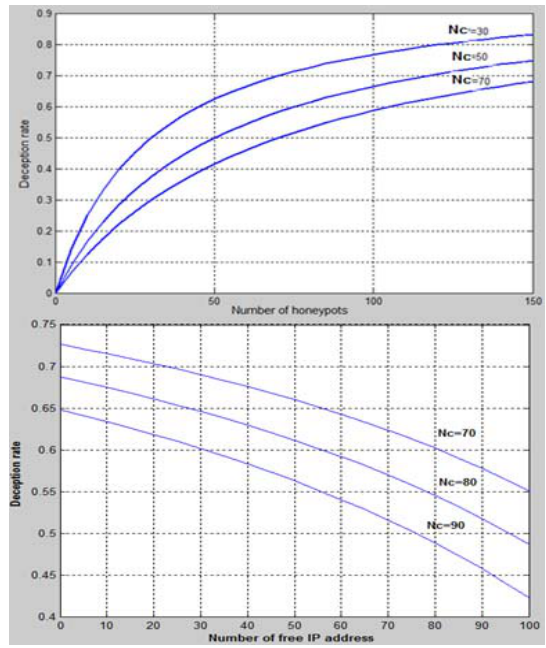
Fig 3 Deception rate of system versus number of honeypots and free IP